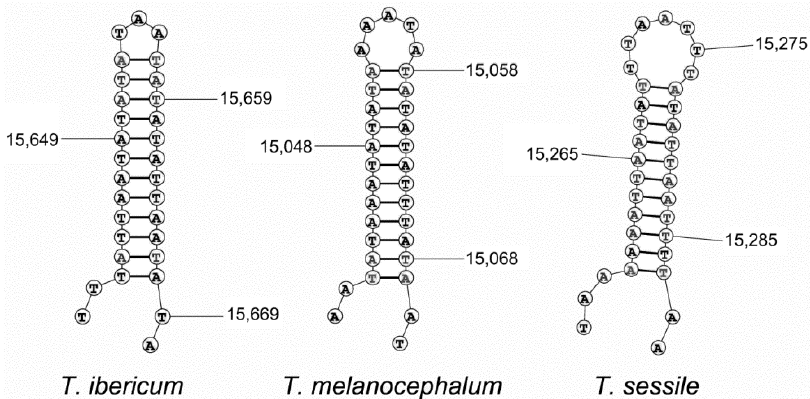
Figure 5. Stem loop structures on last part of the control regions in species from the genus Tapinoma . Some nucleotide positions are indicated.